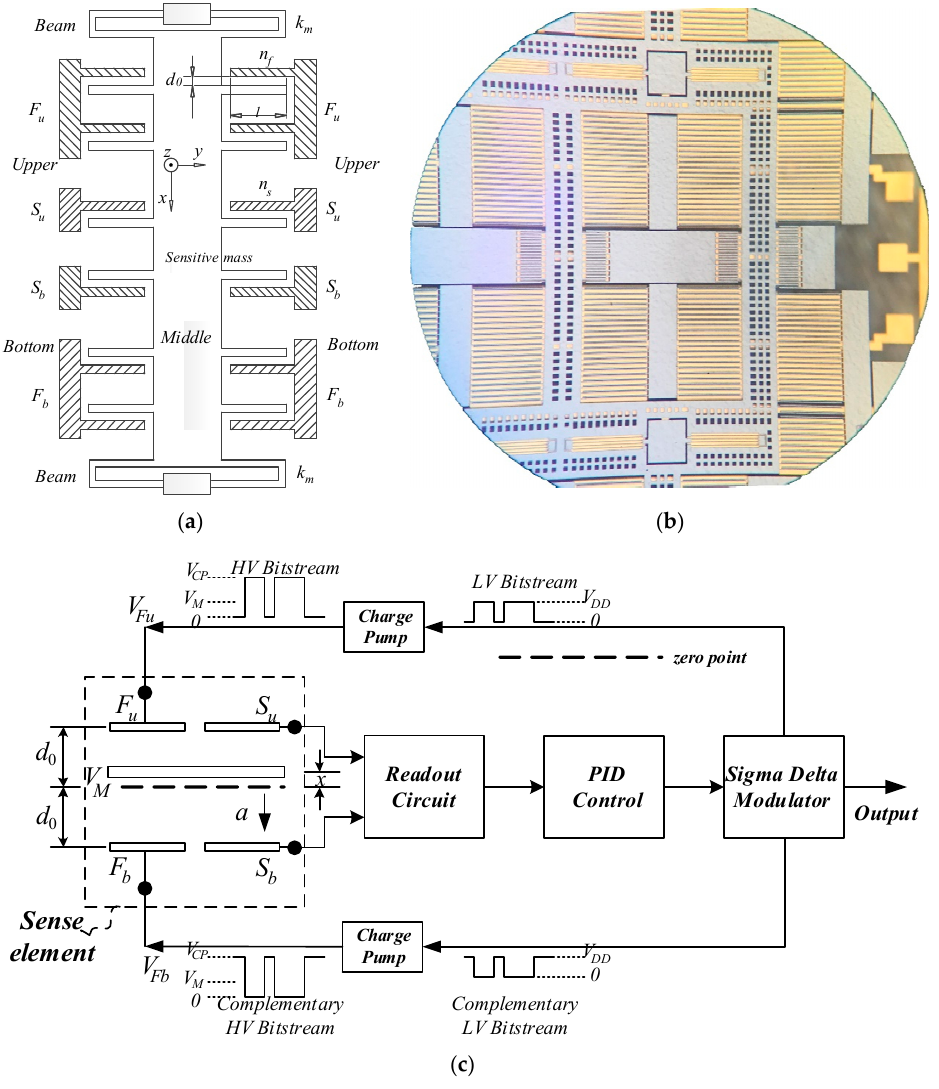
Figure 1. Architecture of the MEMS accelerometer: ( a ) Sense element used in MEMS accelerometer; ( b ) Microphoto of the sense element; ( c ) Scheme of the MEMS accelerometer system. Table 1. Parameters of the sense element used.